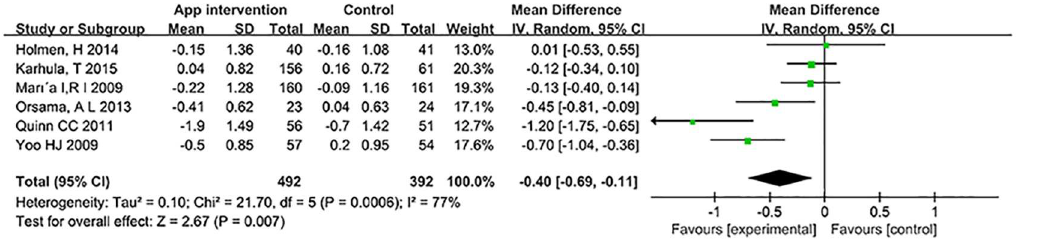
Fig 3. Forest plot for HbA1c level in studies with feedback